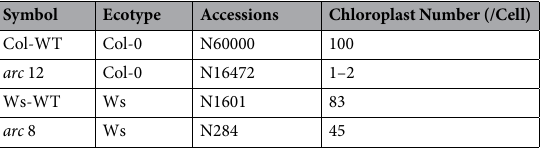
limited by two factors under ambient CO 2 concentrations: leaf biochemistry ( i.e ., the carboxylation capacity of ribulose-1,5-bisphosphate carboxylase/oxygenase; Rubisco) and/or CO 2 supplementation 18 . In C 3 plants, a large amount of total leaf N exists in chloroplasts, mainly forming photosynthetic proteins in the stroma. As a key enzyme in photosynthesis, Rubisco is exceptionally abundant, accounting for approximately half of total leaf N. Because of the large investment of leaf N in Rubisco and electron transport proteins (the latter with approximately 7% of total leaf N), a strong and positive correlation between A and leaf N content per leaf area is frequently observed 17 . Therefore, increasing the chloroplast volume per unit leaf area, and hence increasing the leaf N con- tent, would potentially increase the rate of photosynthesis. Under a given environmental condition ( i.e . temperature and light), the carboxylation to oxygenation ratio of RuBP is determined by the CO 2 concentration in the chloroplast ( C c ) 19–23 . CO 2 molecules diffuse from the atmosphere into chloroplasts by overcoming a series of diffusion resistances, including the boundary layer, sto- mata and mesophyll resistances, which results in a remarkable drawdown in C c compared to the atmospheric CO 2 concentration. The diffusion conductances of stomata and mesophyll tissues are defined as stomatal conductance ( g s ) and g m , respectively. In the last 10–15 years, considerable efforts have been focused on the chloroplast features that determine g m . These have shown that there is a tight relationship between the area of chloroplast surface exposed to intercellular airspaces ( S c ) and g m22, 24–26 . In mesophyll cells, chloroplasts are usually located next to the cytoplasmic membrane adjacent to intercellular air spaces, which was suggested to decrease resistance to CO 2 diffusion 25 . Smaller chloroplasts are more flexible in movement than larger chloroplasts, especially under variable